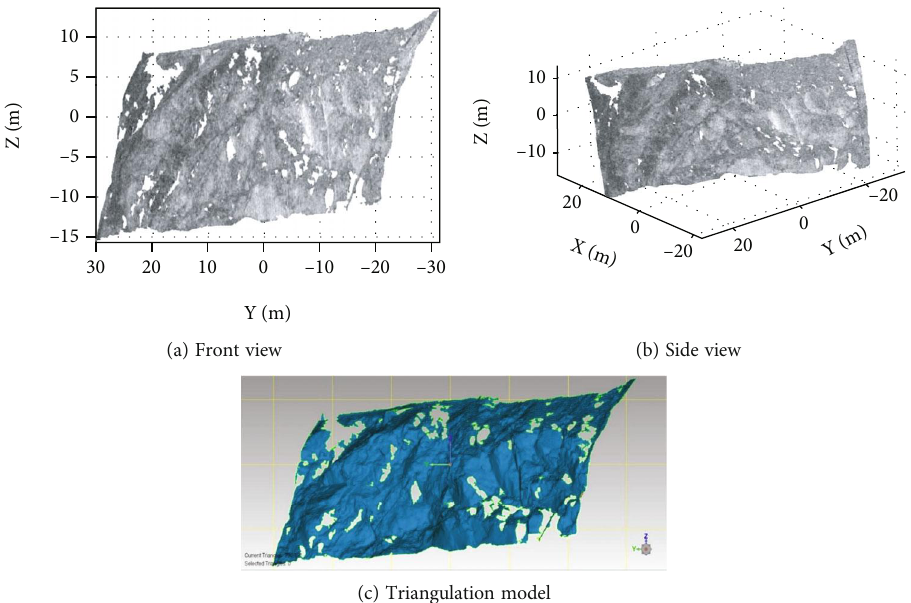
Figure 3: S8 station scanning slope point cloud data.